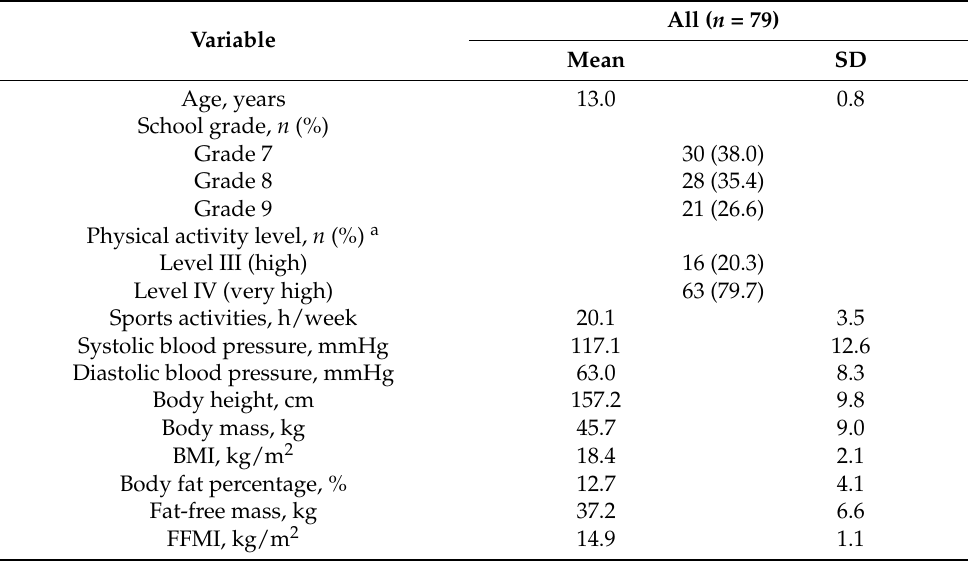
Table 1. Basic characteristics of the study participants (mean values and standard deviations or number and percentages).